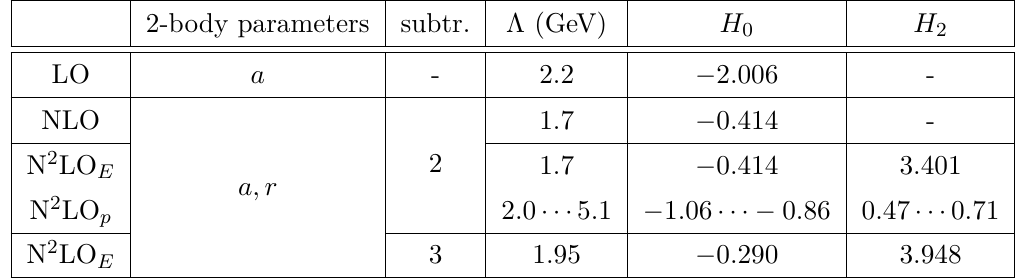
Table 2 . The values of the parameters used in the finite-volume calculations. The symbol “N 2 LO denotes the E ( p ) -scheme at the next-to-next-to-leading order. For the p -scheme the case of three subtractions was not